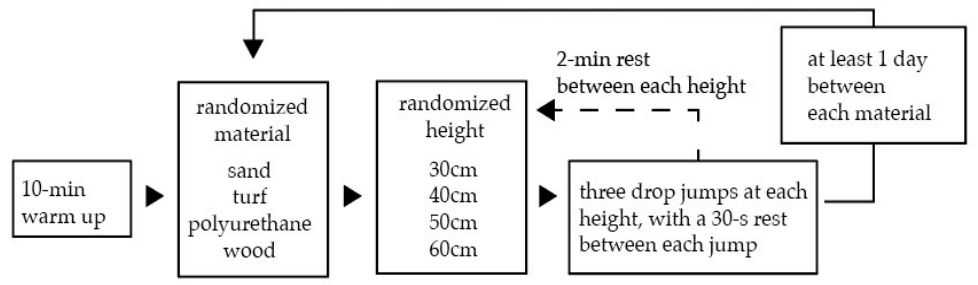
Figure 1. Experimental procedures.